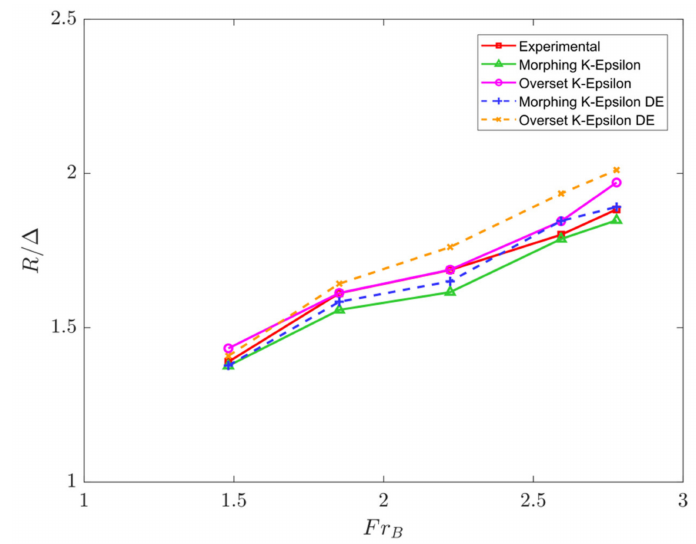
Figure 9. As of Figure 6, but for